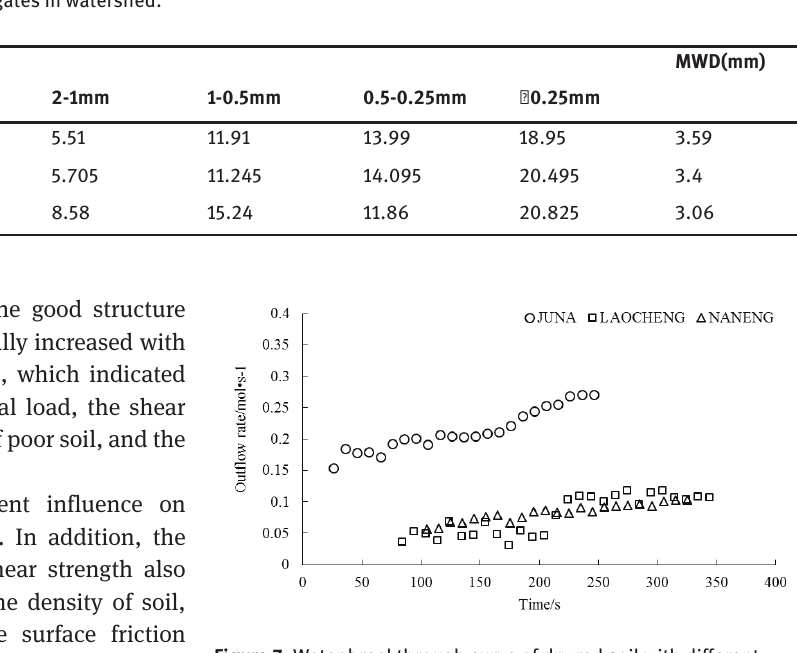
Figure 7: Water breakthrough curve of dry red soil with different structure in River Basin.